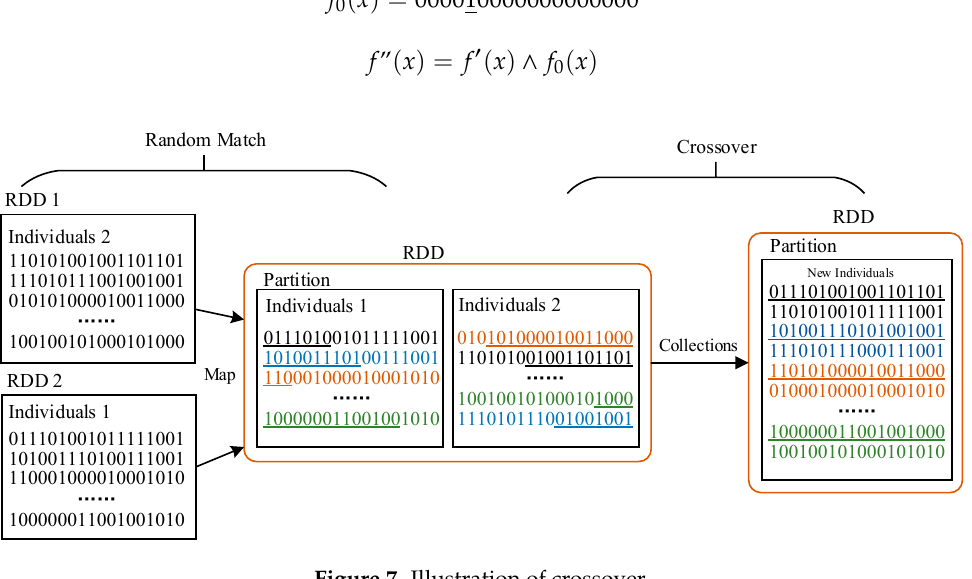
Figure 7. Illustration of crossover.